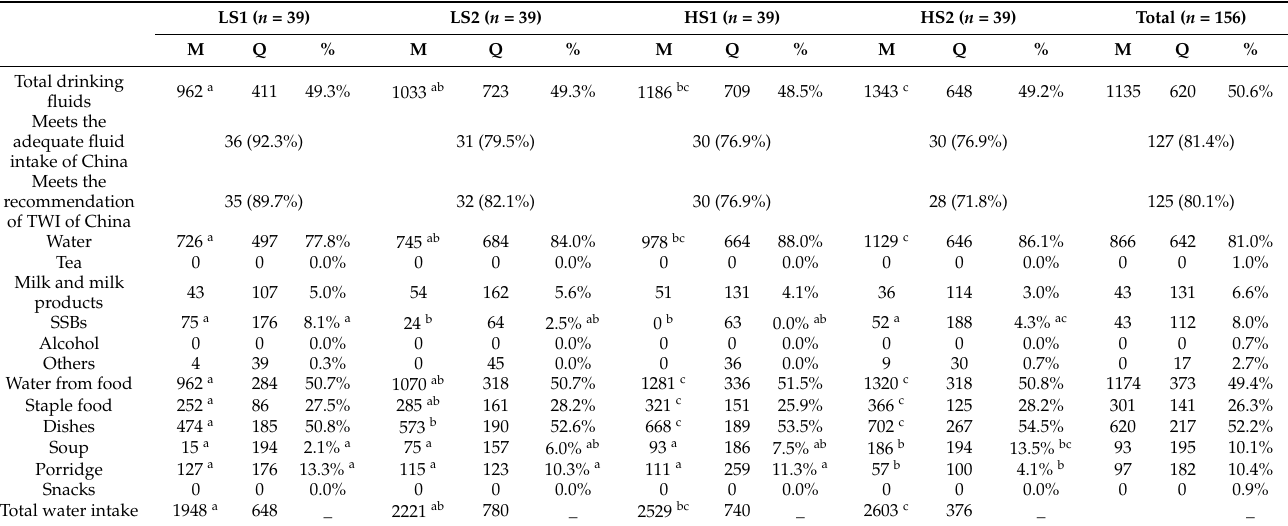
Table 2. The TWI, total drinking fluids and water from food among